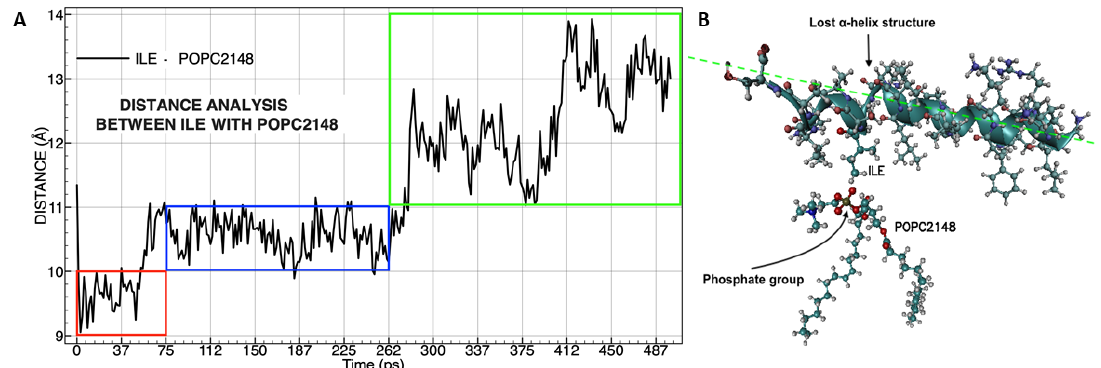
Figure 9. Molecular distances analysis between isoleucine (ILE17) with phosphatidylcholine ( A ), the color frames represent three times of a ffi nity during molecular dynamics. Molecular representation was taken during peptide insertion into the membrane ( B ). The specific forces of van der Waals called dipole–dipole forces are represented between the phosphate group (polar) in POPC and the side chain (non-polar) of ILE (C-H—-O-P). The green dotted line shows the change of the spatial position of peptide + 5 that causes the loss of α -helix structure and displacement of the LVKGIS